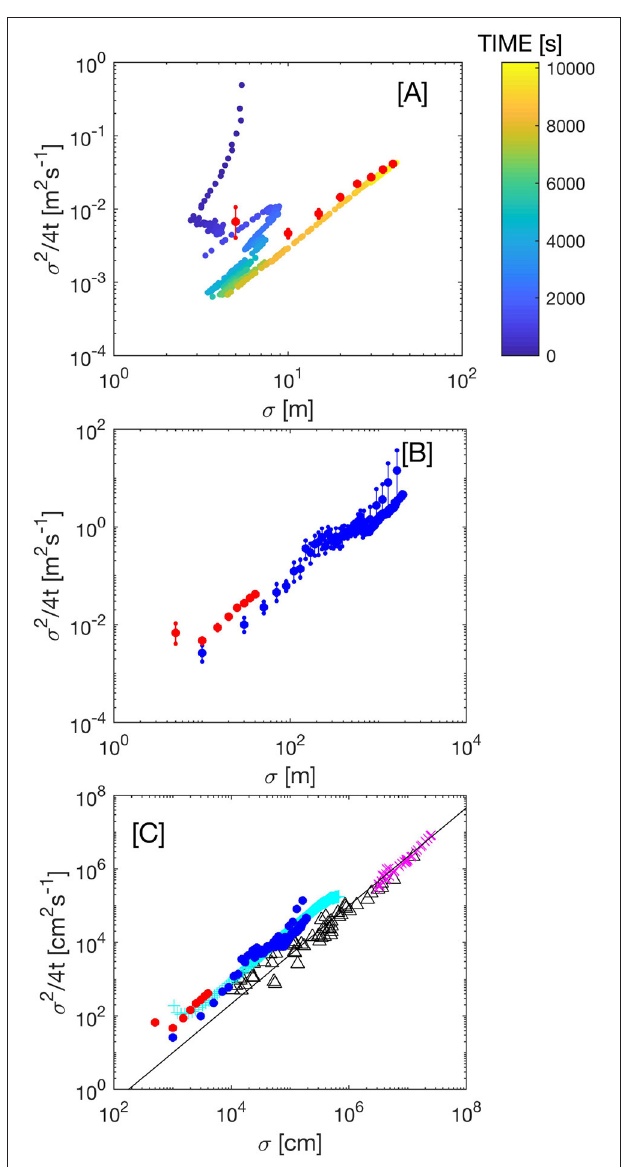
FIGURE 13 | (A) STARRS scale-dependent diffusivities, color-coded according to time since deployment, and bin-averaged diffusivities (red dots). (B) Bin averaged STARSS (red) and surface drifter (blue) diffusivities. The large dots represent bootstrap estimates of the mean and the vertical lines represent 95% confidence intervals. (C) Previous results Okubo (1971), Poje et al. (2014), and Mensa et al. (2015) are represented by black triangles, pink ‘x’s, and light blue ‘+’s. Richardson scaling ( K ∼ σ 4 / 3 ) is shown as a solid black line.